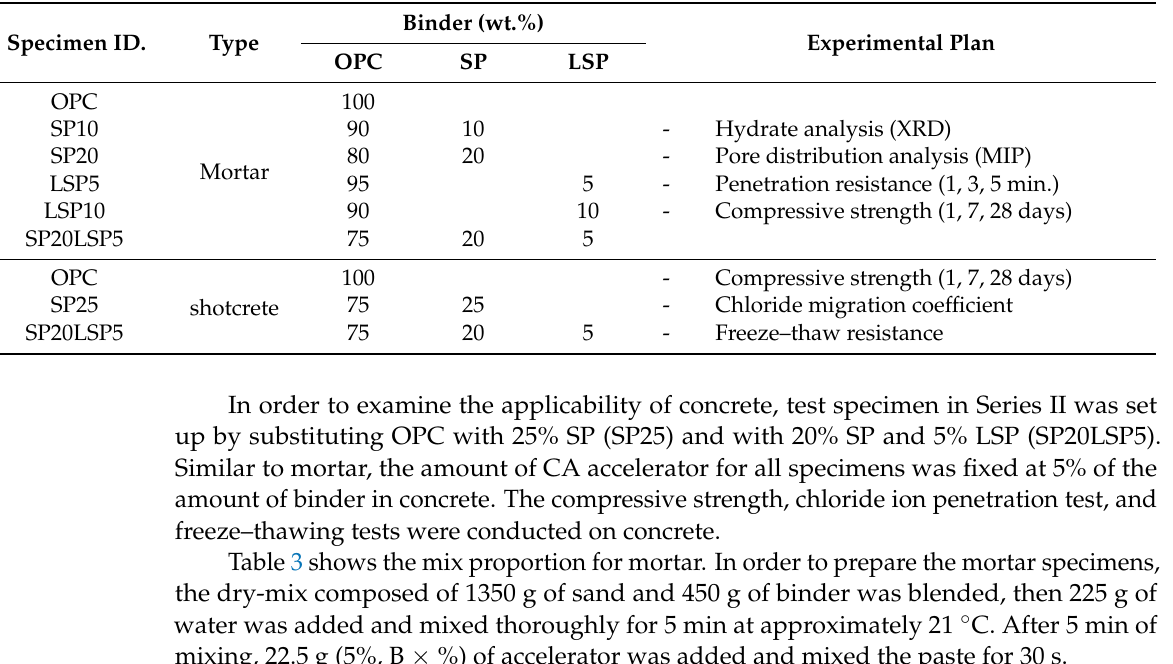
Table 2. Experimental plan.